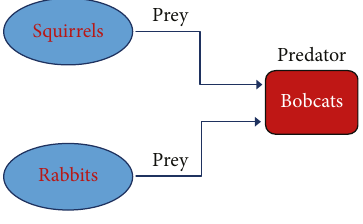
Figure 1: Prey-predator model